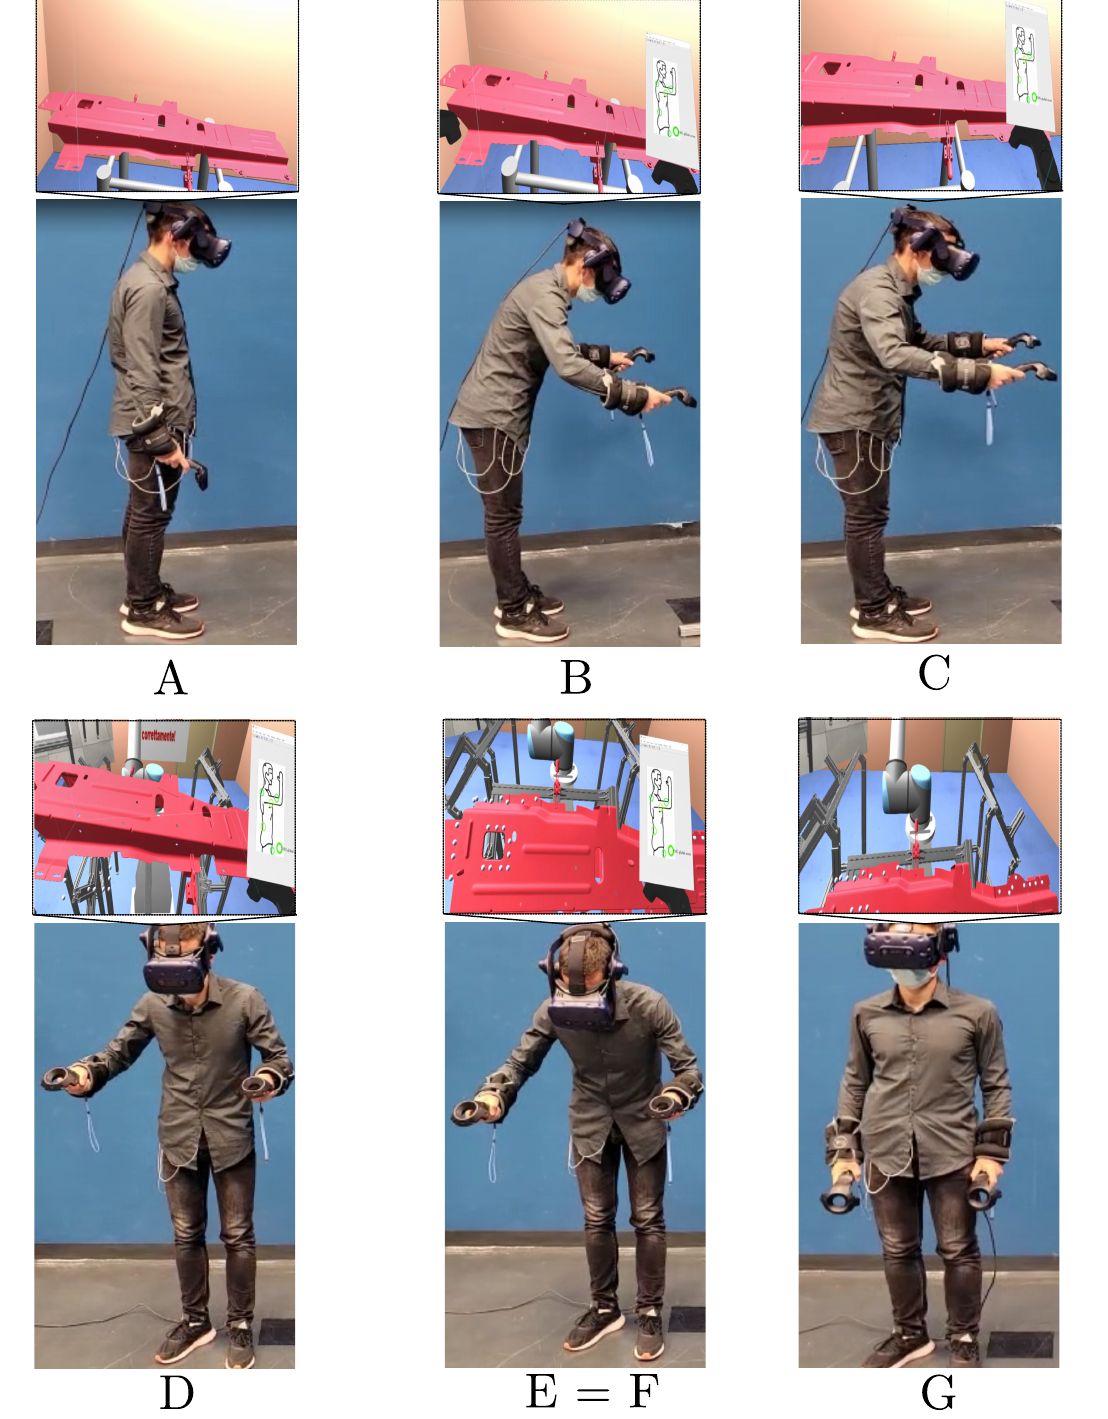
Figure 5. The events of the real task, and the associated view in the virtual environment (placed above in the block over the related real figure), corresponding to ( A ) beginning of BRG phase, ( B ) end of BRG phase: grasping event, ( C ) end event of the ABG , ( D ) beginning event of BR phase, ( E = F ) events during the P , ( G ) end event of the ABP phase. Notice that events E and F are both represented in the same picture, because the subject is in the same